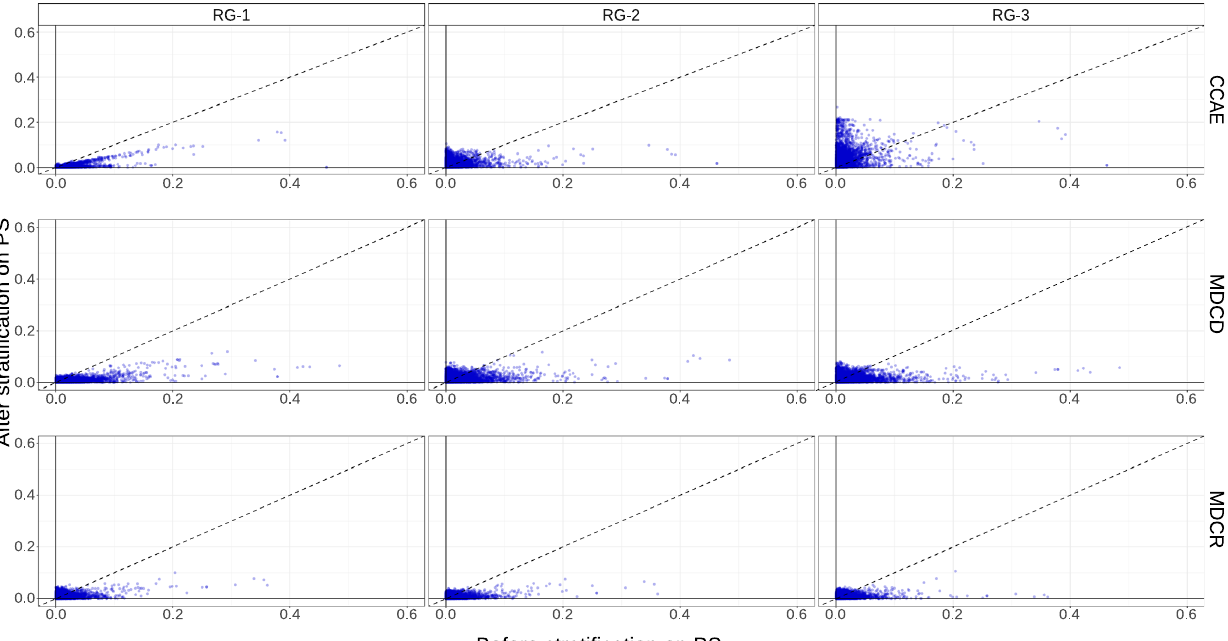
Fig. 3 Covariate balance. Patient characteristic balance for thiazide or thiazide-like diuretics and ACE inhibitors before and after strati fi cation on the propensity scores. RG-1 represents patients with acute MI risk lower than 1%; RG-2 represents patients with acute MI risk between 1% and 1.5%; RG-3 represents patients with acute MI risk larger than 1.5%. Each point represents the standardized difference of means for a single covariate before (x-axis) and after (y-axis) strati fi cation. A commonly used rule of thumb suggests that standardized mean differences above 0.1 after propensity score adjustment indicate insuf fi cient covariate